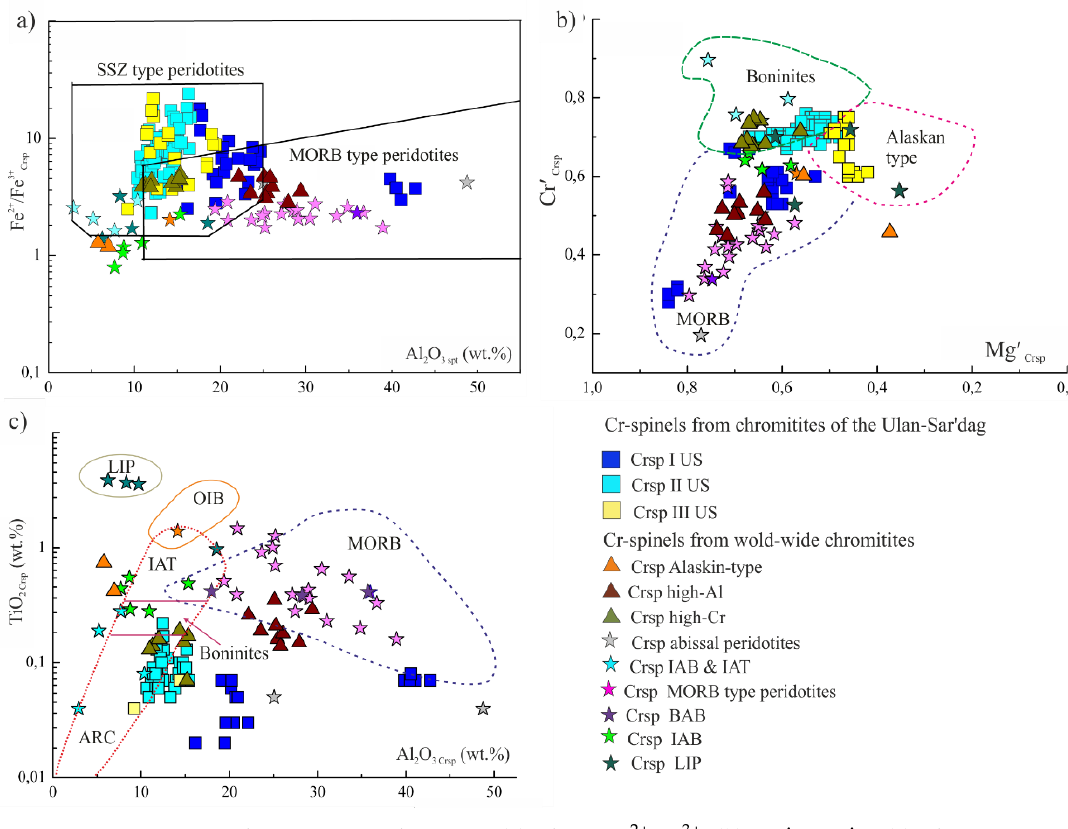
Figure 14. Tectonic discrimination diagrams: ( a ) Al 2 O 3 –Fe 2+ /Fe 3+ ; ( b ) Mg′ sp –Cr′ sp ; ( c ) Al 2 O 3 –TiO 2 from the chromitites of the USO and chrome spinels of chromitites from all over the world. The chrome spinels’ composition fields for peridotites from different geodynamic settings are drawn from [18].